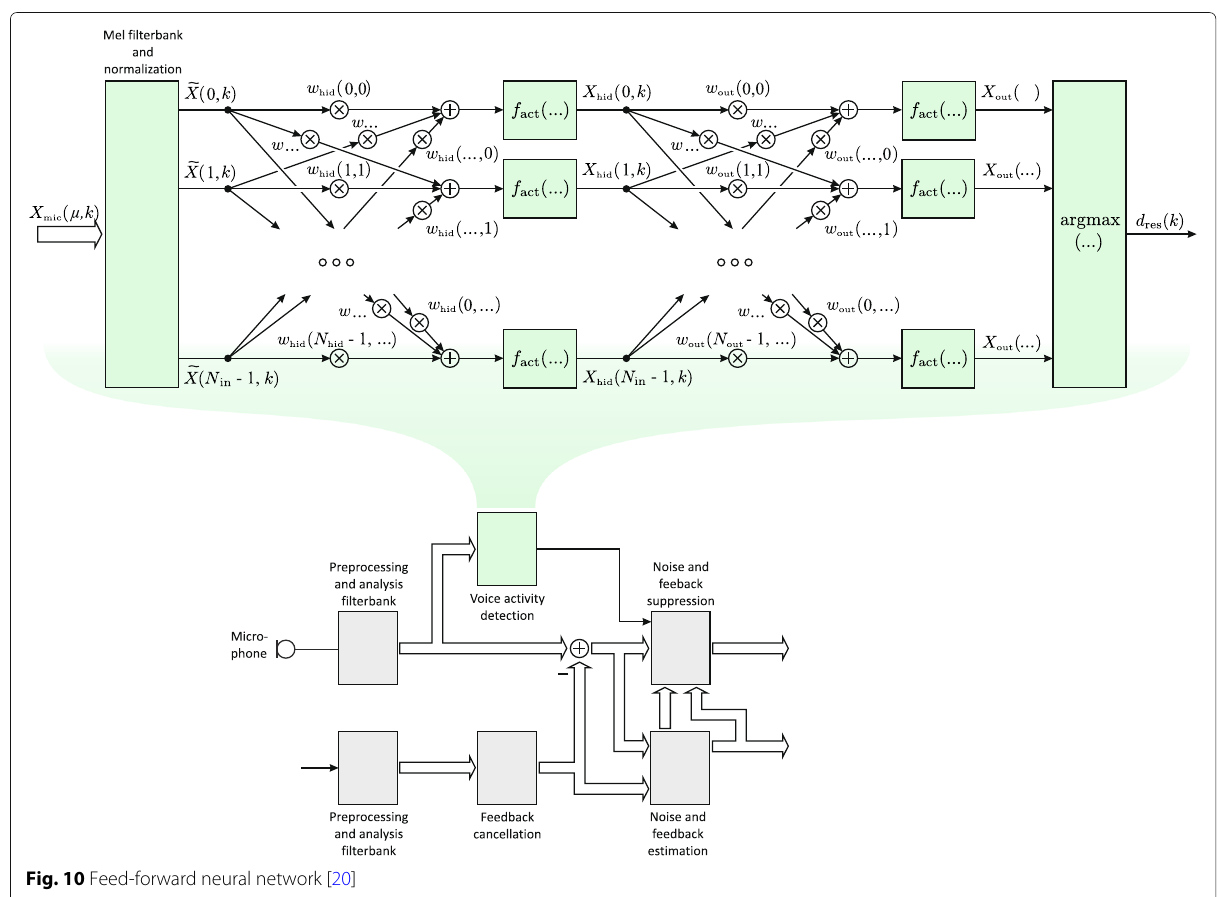
Fig. 10 Feed-forward neural network [20]